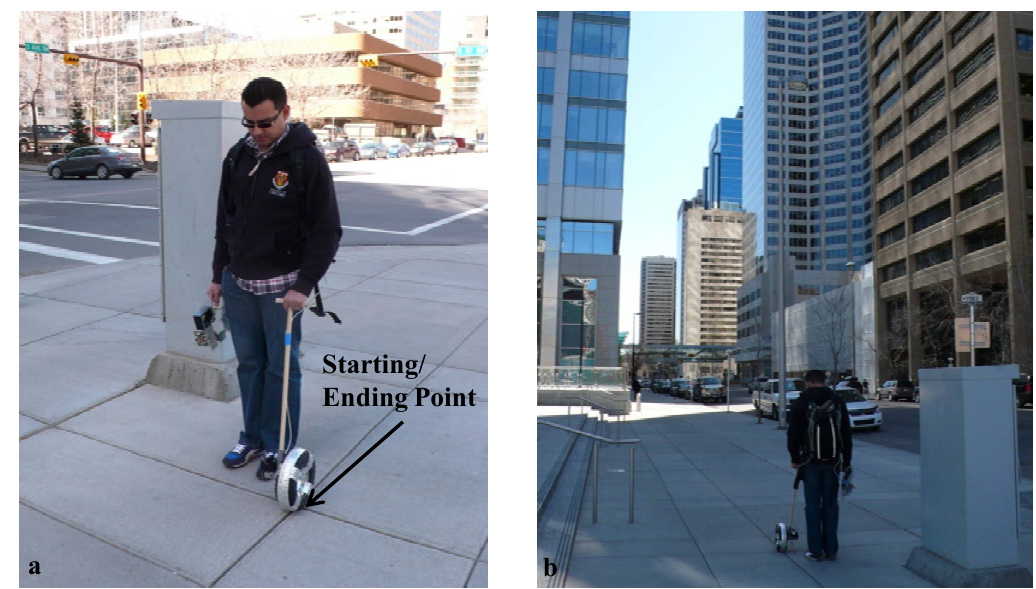
Figure 10. Data collection in downtown Calgary.